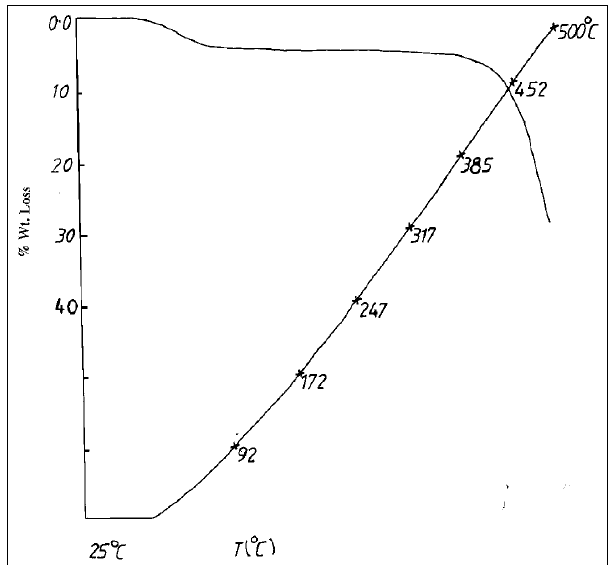
Figure 9. TGA on emeraldine base (EB) powder. The TGA experiment was carried out